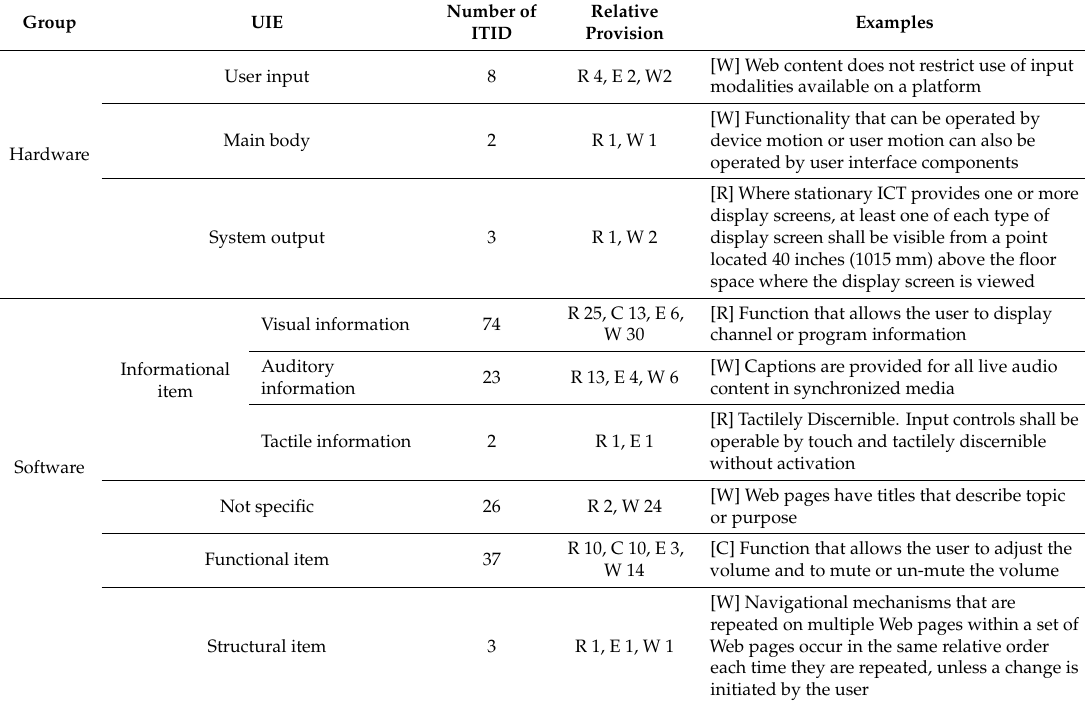
Table 8. Numbers of provisions related to each UIE.